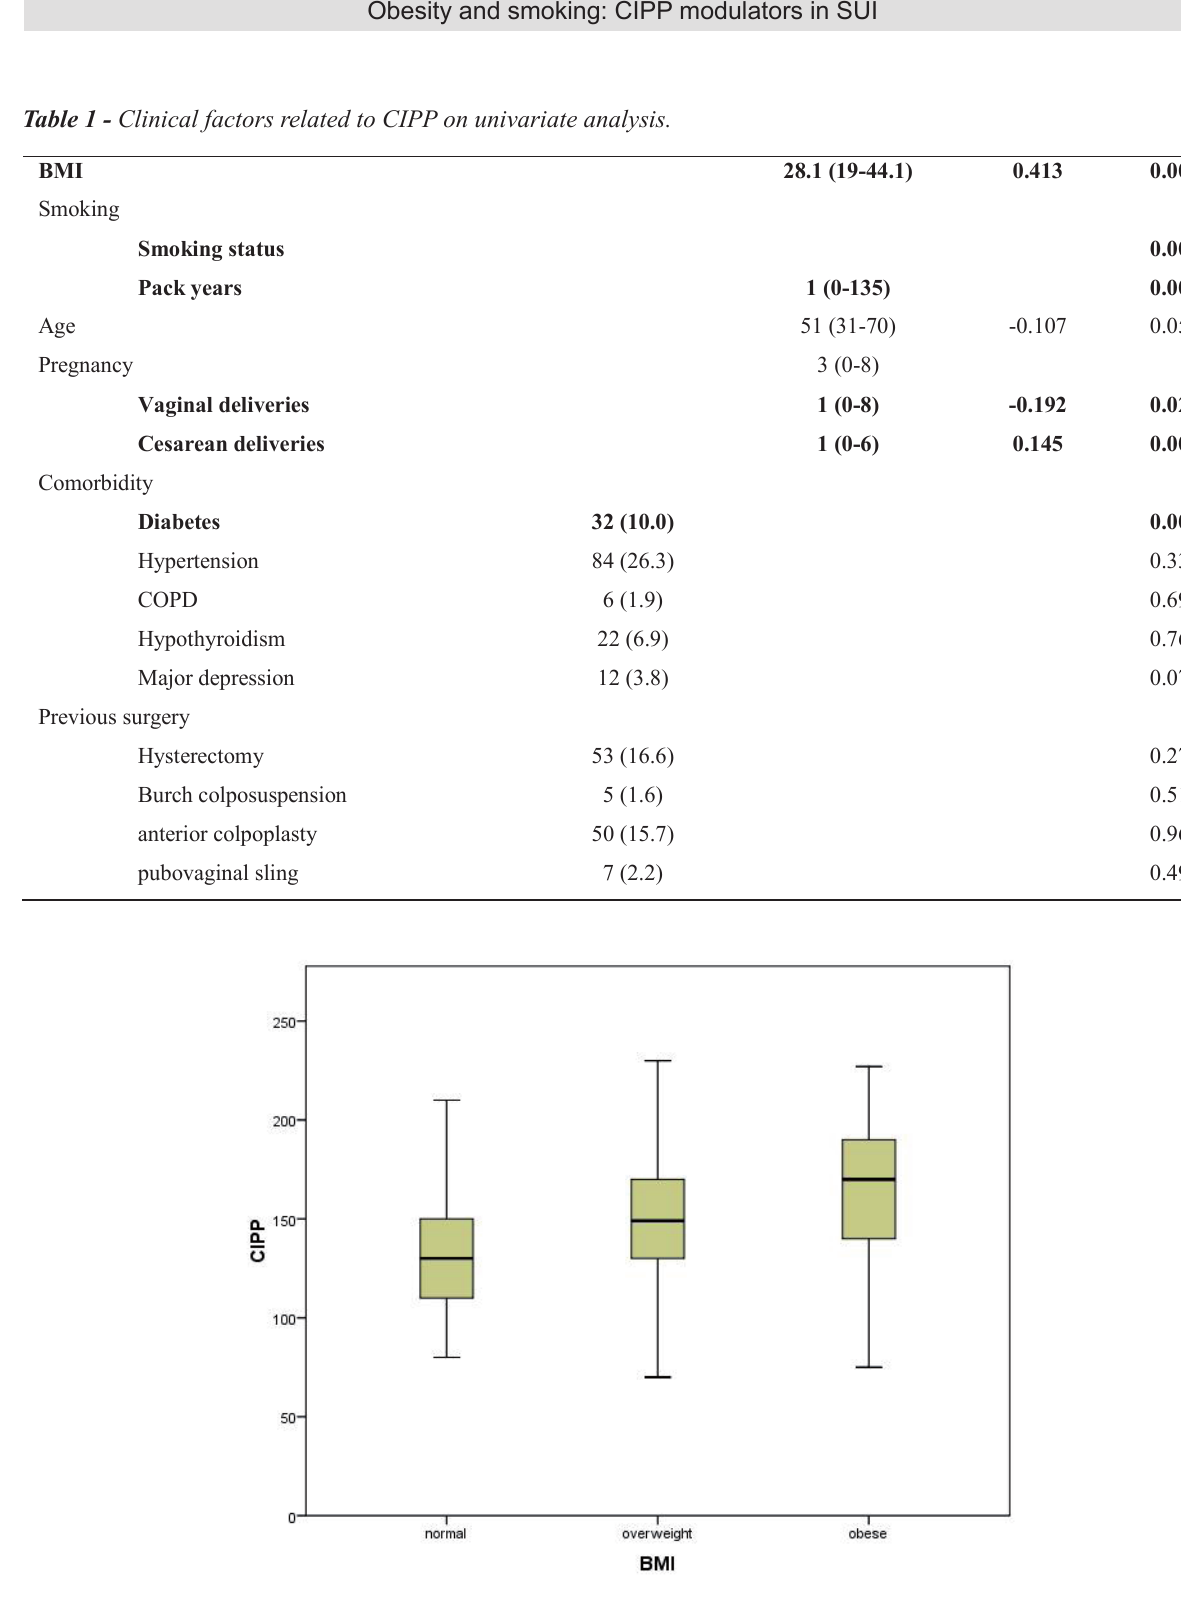
Figure 1 - CIPP (cmH